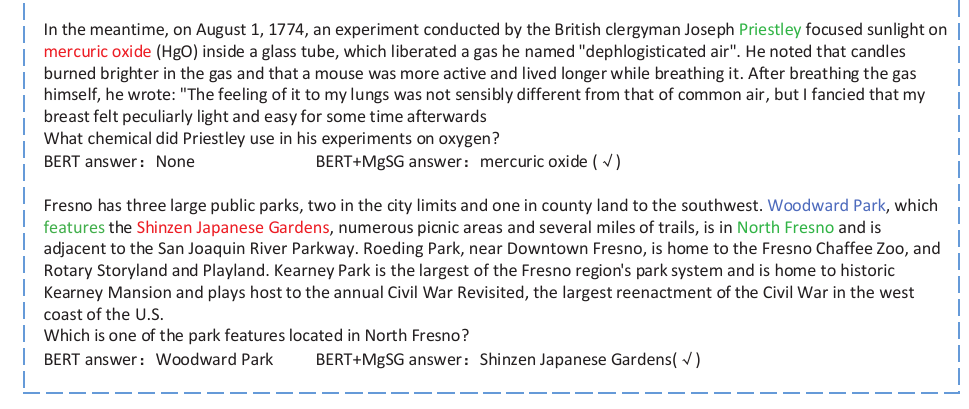
Figure 7. The red font represents the correct answer, blue font represents the wrong answer, green fonts represent keywords or information in the question.